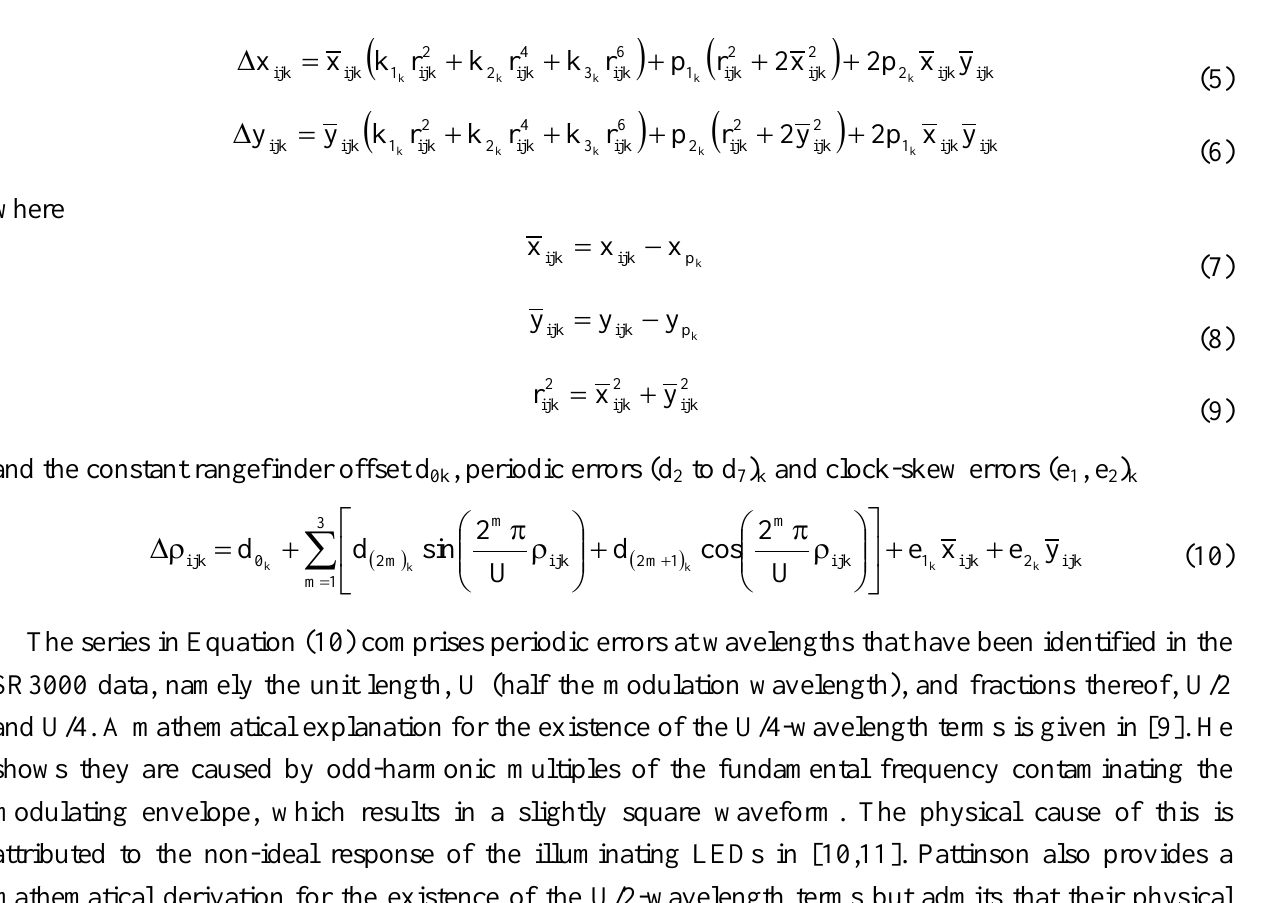
Figure 1. First, an established procedure [8] is used for the camera-lens calibration from x and y observations of targets in a network of convergent images. Then, a planar target is imaged at normal incidence (the normal images) to determine the range-error parameters. The authors of [3] perform their range-error calibration using a small, planar target moved along an interferometric calibration track that allows very accurate camera-target positioning. An extended, featureless planar surface is used in [4] and the camera-plane orientation is established with two parallel tape measures. The orientation can also be performed by space resection of the camera from independently-surveyed targets on the plane, which is the procedure adopted for the testing described herein. Regardless of the orientation method used, reference ranges between each camera’s perspective centre and the target surface are computed using the point observations in the already-oriented normal images and the estimated camera-lens parameters. These are compared with the observed ranges to derive the range differences,  , from which the range-error parameters are estimated by